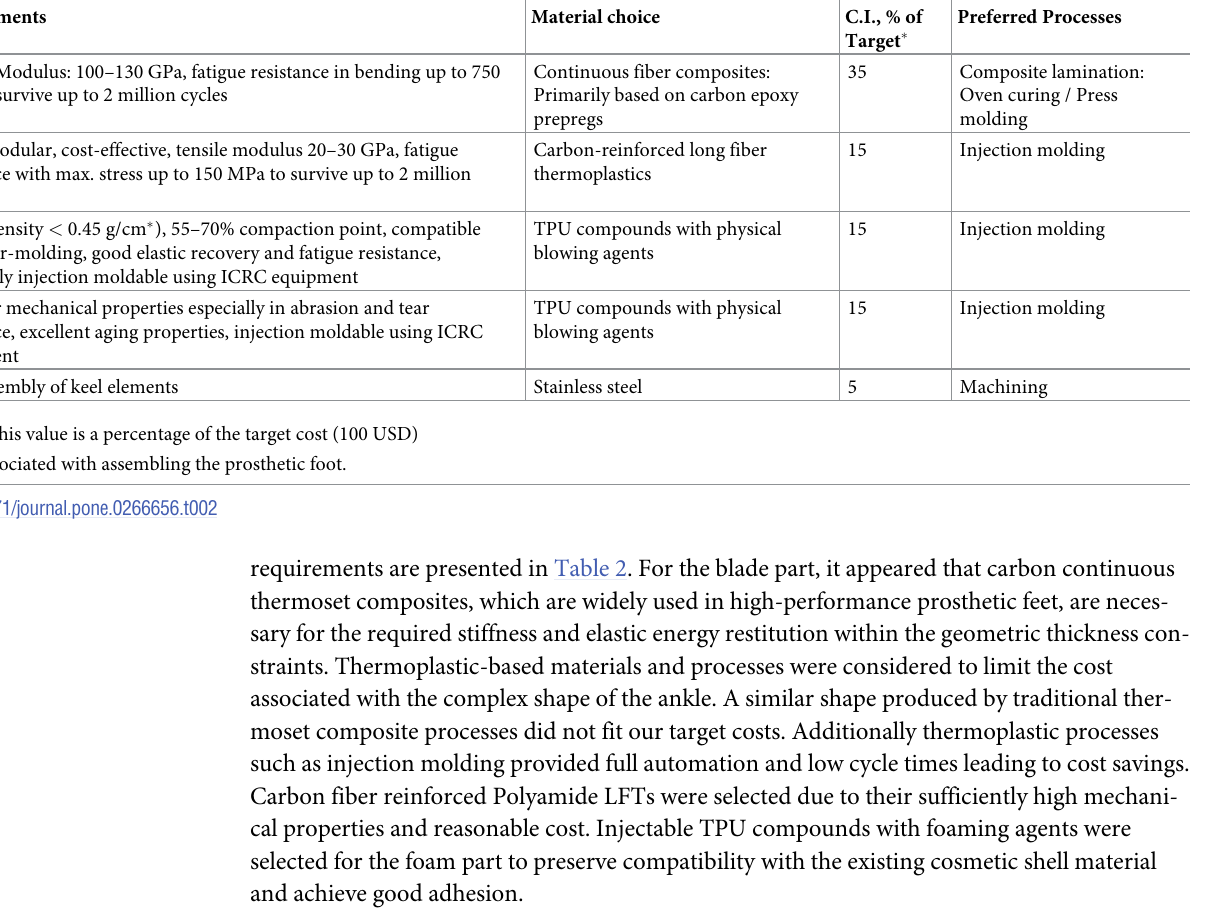
Table 2. Choice of materials and process satisfying the cost requirements & .